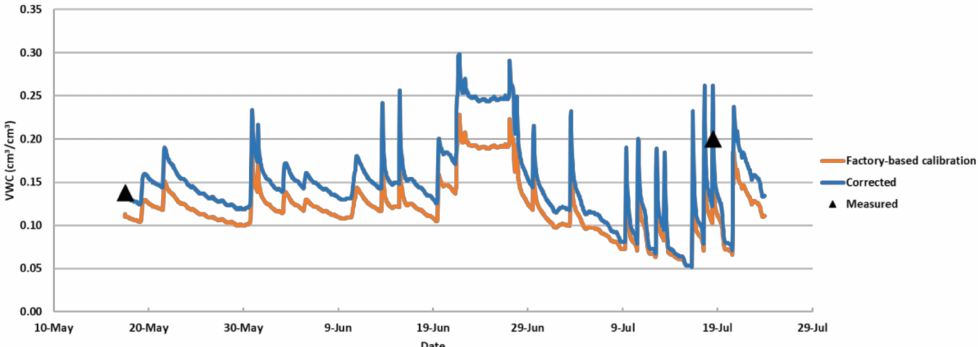
Figure 6. Comparison of factory-based calibration to corrected values for CS616 in loamy sand.